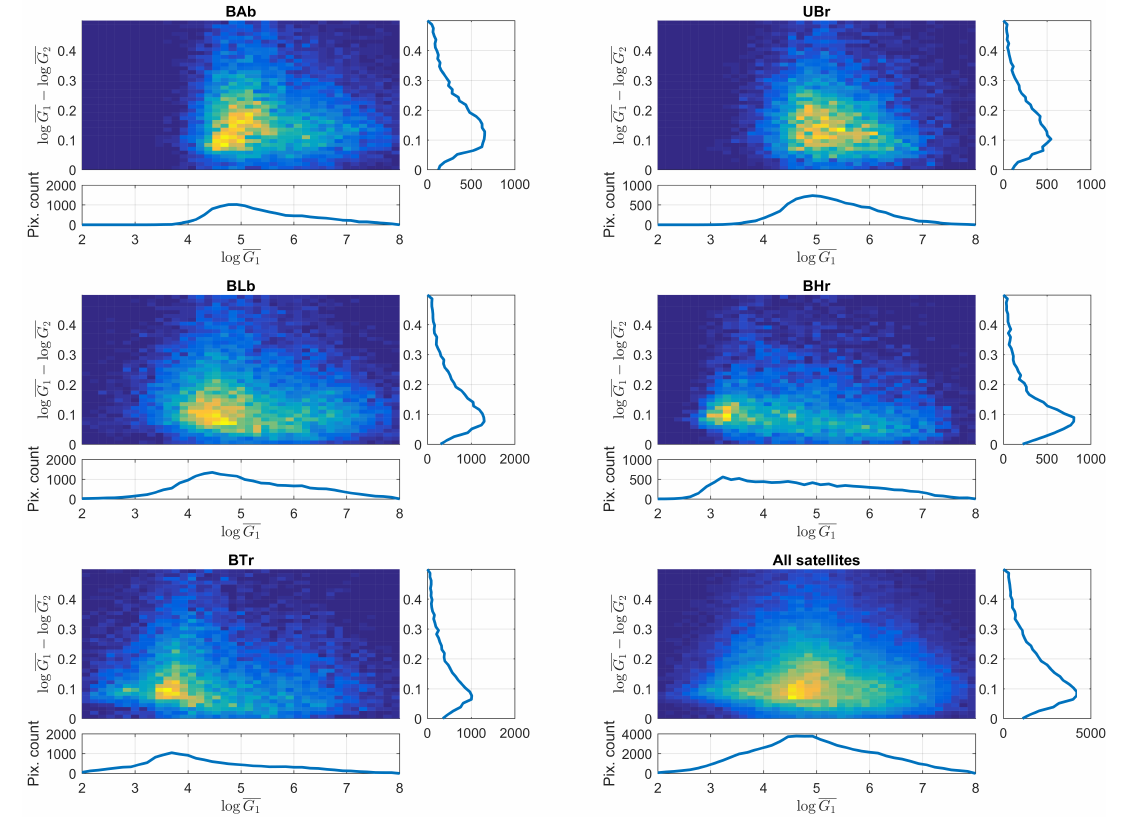
Figure 11. Dependencies between the prefactors in bistable